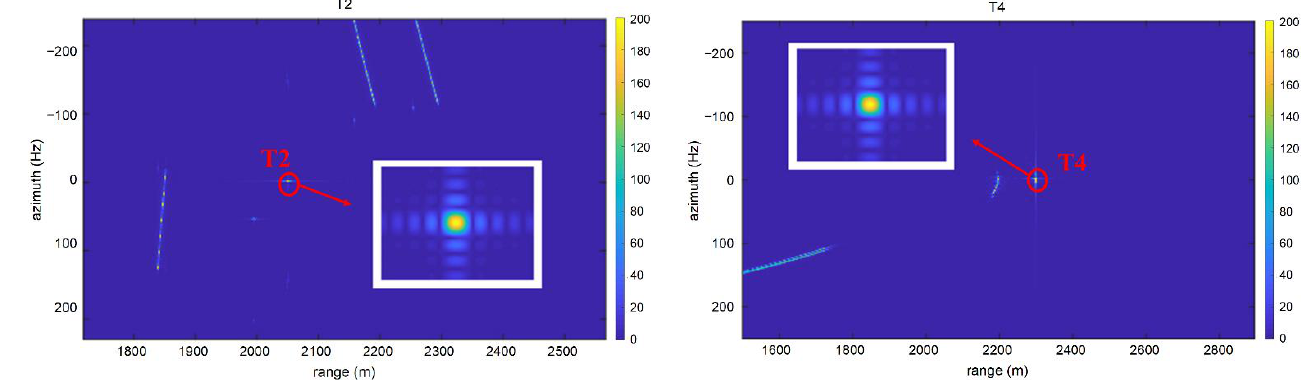
Figure 10. Refocused result of the moving target T2 and T4.